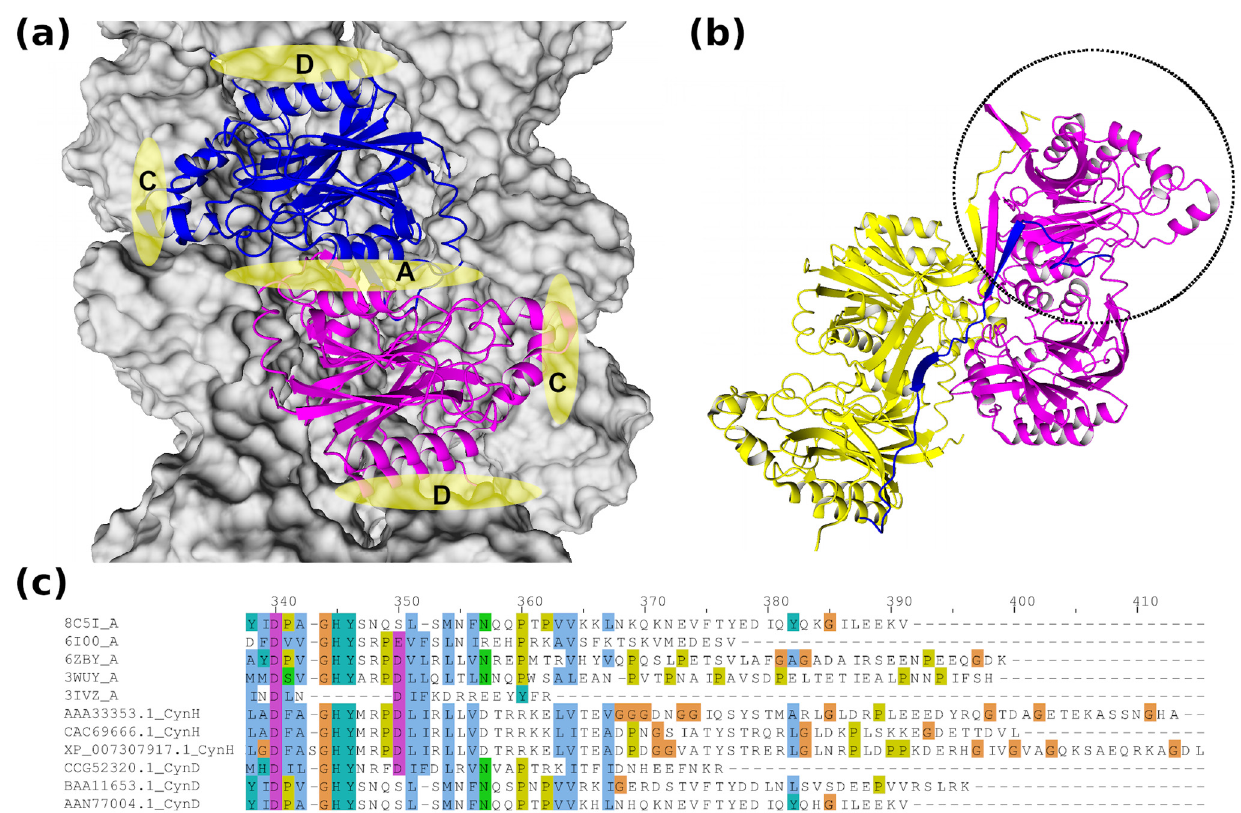
Figure 5. ( a ) Contact interfaces in the helical form of CynD pum . The monomers in one of the dimers are shown in magenta and blue and the rest of the helix is shown by surface representation. Contact interfaces are highlighted in yellow and labeled. The A interface is formed between monomers in a dimer, the C interface is formed between two dimers in the helix, and the D interface is formed between helical turns. ( b ) Adjacent dimers (colored differently). The C-terminal part of the encircled monomer is highlighted in blue to visualize its 3-D orientation. ( c ) Multiple sequence alignment of the C-terminal regions of CynD pum mutant (pdb 8c5i), Nit4 from Arabidopsis thaliana (pdb 6i00) [54], nitrilase from Pseudomonas fluorescens EBC191 (pdb 6zby), nitrilase from Synechocystis sp. PCC6803 (pdb 3wuy) [56], nitrilase-superfamily enzyme from Pyrococcus abyssi (pdb 3ivz) re- classified from nitrilase to amidase [36], CynH from Microdochium sorghi (AAA33353.1) [27], CynH from Fusarium solani (CAC69666.1) [35], CynH from Stereum hirsutum (XP_007307917.1) [15], CynD from Flavobacterium indicum (CCG52320.1) [20], CynD from Stutzerimonas stutzeri (BAA11653.1), and CynD from Bacillus pumilus (AAN77004.1)